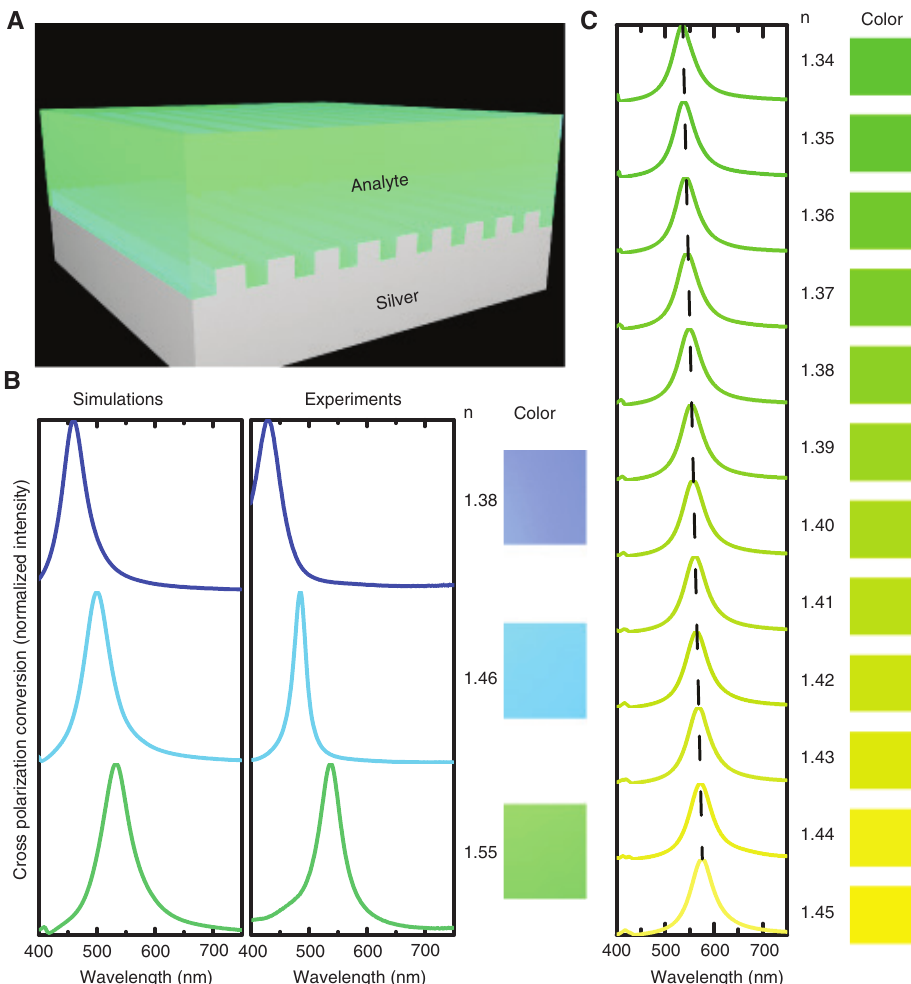
Figure 5: Color sensing and detection of the refractive index by tuning the resonant wavelength. (A) Schematic of the simple fluid solution detector used for refractive index sensing. (B) Simulated and experimental spectra of the PSG coated by MgF and PMMA ( n = 1.55). The experimentally measured colorimetric responses of the PSG are depicted at the right of the experimental spectra. (C) Calculated cross-polarized reflection spectra of the PSG when the environmental refractive index varies from 1.34 to 1.45 nm. The cor- responding colorimetric responses locate at the right side. All the values are normalized to their respective